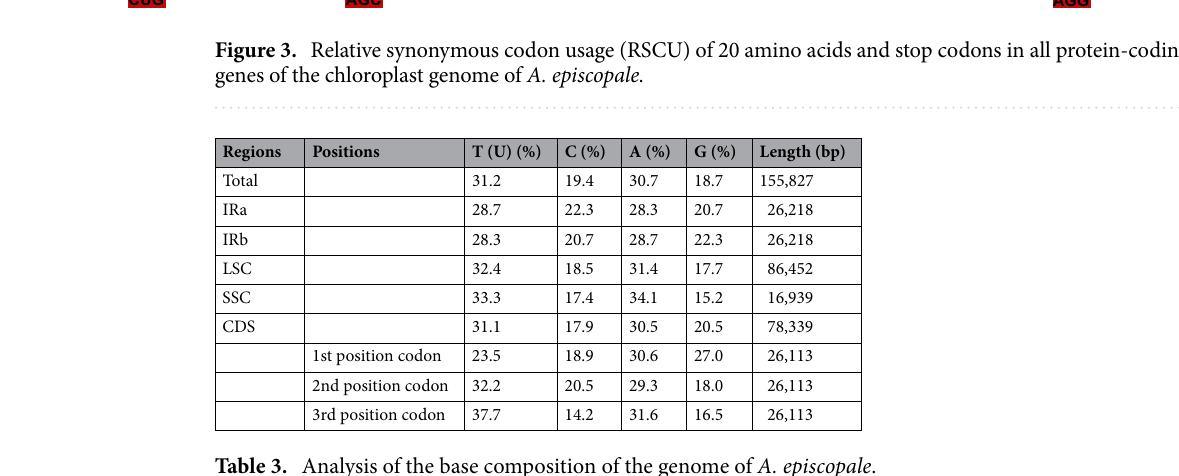
codons encoded 20 amino acids, and the remaining three were found to be stop codons. Methionine (Met) and tryptophan (Try) are encoded by only one codon, whereas 2–6 codons encoded the remaining amino acids (Fig. 3). Of the 64 codons encoded by the protein-coding sequence of the A . episcopale chloroplast genome, 30 had the RSCU values > 1, which were high-frequency codons. Among them, 16 codons were ending in U, 13 codons ending in A, and one codon ending in G, indicating that the third base of the high-frequency codon of A . episcopale chloroplast genome prefers to use A or U (T) (Table S2). Base composition of genome analysis. The base composition of LSC, SSC, IRS regions, and codons at different positions in the chloroplast genome of A. episcopale was analyzed (Table 3). In the LSC, SSC, and IRs region, AT content of SSC was the highest, followed by the LSC region and IRs region. The first, second, and third codon positions were 26,113 bp in length, and they had thymine (T) contents of 23.5–37.7%, cytosine (C) of 14.2–18.9%, adenine (A) of 28.3–31.6%, and guanine (G) of 16.5–27.0% (Table 3). The results indicated that the AT content of the chloroplast genome was higher than the GC content and also demonstrated the codon preference for using bases A and T(U). Simple sequence repeat (SSR) analyses. SSRs are highly variable molecular markers within the same species and are mainly used in population genetics and polymorphism studies. These are important for gene expression, transcriptional regulation, and chromosome construction 13,14 . We investigated the type, distribution, and frequency of the repeat types of SSRs in the cp genome of A. episcopale . A total of 64 SSRs were identified